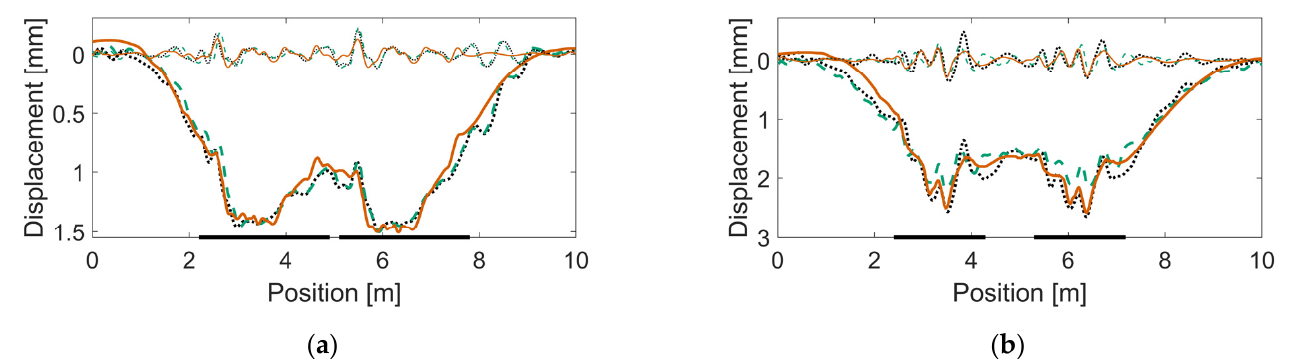
thick, horizontal lines on the frame of the figures show the regions of the crossing rail scan.